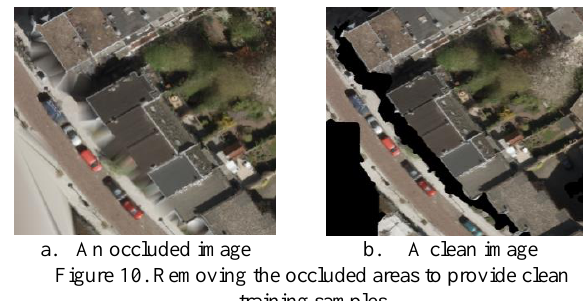
assigned as a non-building class.